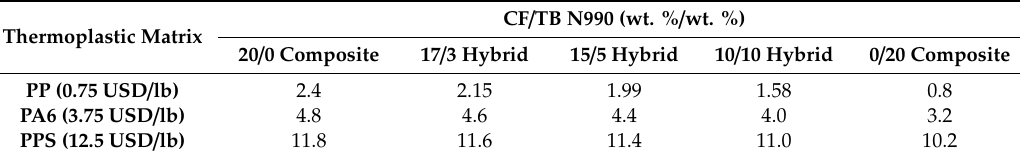
Table 7. Estimated materials costs (USD / lb) of composites and